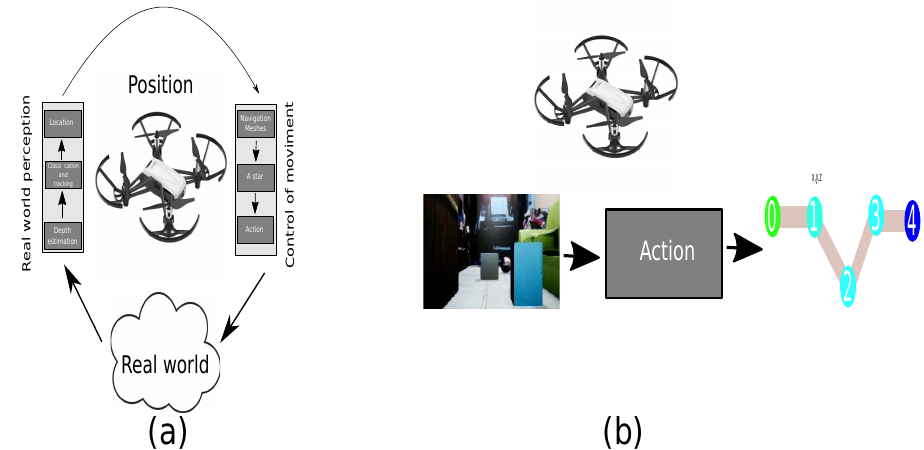
Figure 10. Path-planing architecture. ( a ) Standard architecture. ( b ) Reduced architecture.